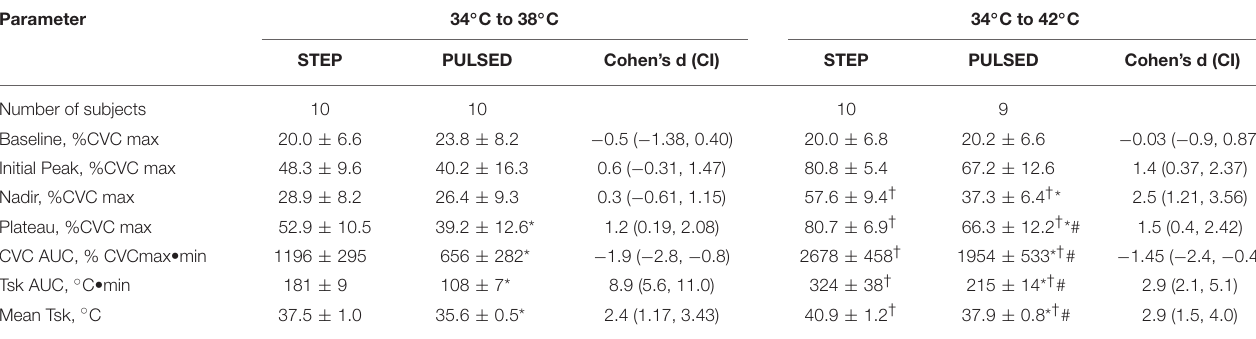
TABLE 1 | Biphasic skin blood flow response